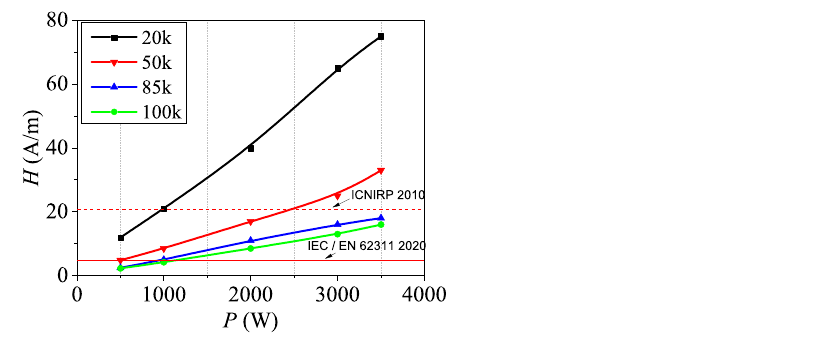
Figure 5. Curves of H -field strength at various frequencies and power